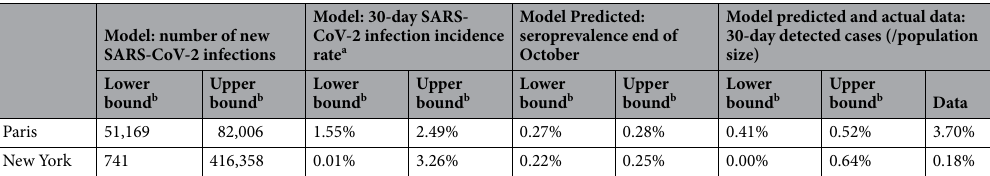
Table 1. Model-projected COVID-19 outcomes and actual reported data for the cities of Paris and New York from September 15 to October 31, 2020. a New SARS-CoV-2 infections occurring between September 15 and October 31, 2020 were converted to a 30-day incidence rate for comparability. b The lower and upper bounds were taken as the minimum and maximum median values, respectively, of the five scenarios